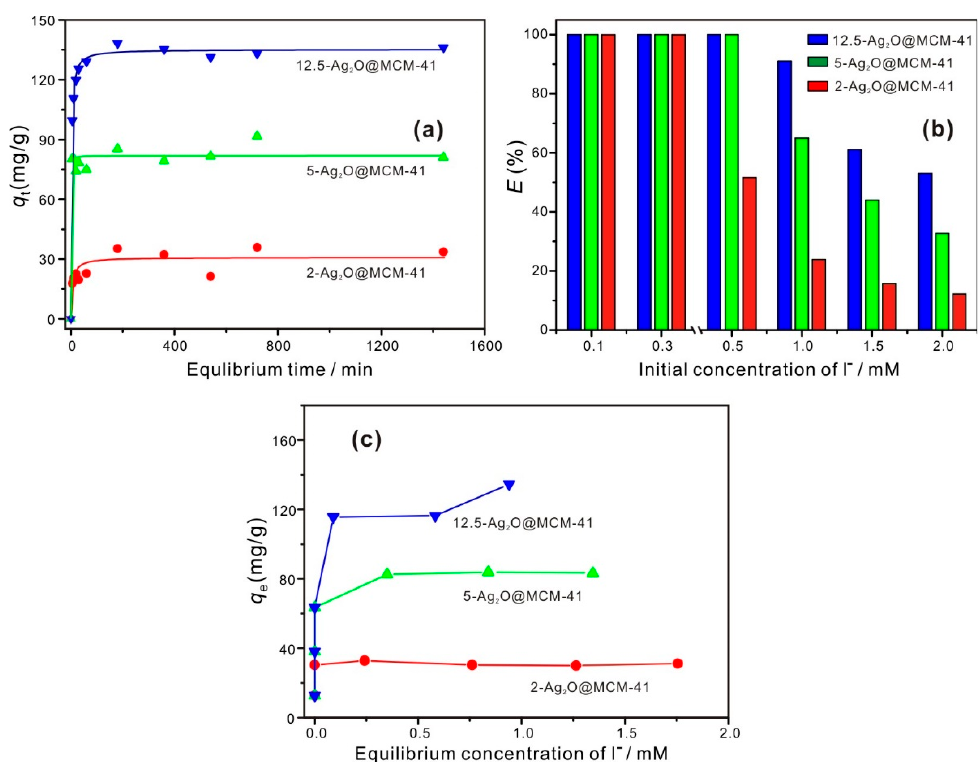
Figure 4. ( a ) The adsorption kinetic curves of I − on the Ag 2 O@MCM-41 nanomaterials; ( b ) the re- moval efficiency (E) of I − at different initial concentrations by the Ag 2 O@MCM-41 nanomaterials; ( c ) adsorption isotherms of I − on the Ag 2 O@MCM-41 nanomaterials. ( c ) adsorption isotherms of I − on the Ag 2 O@MCM-41